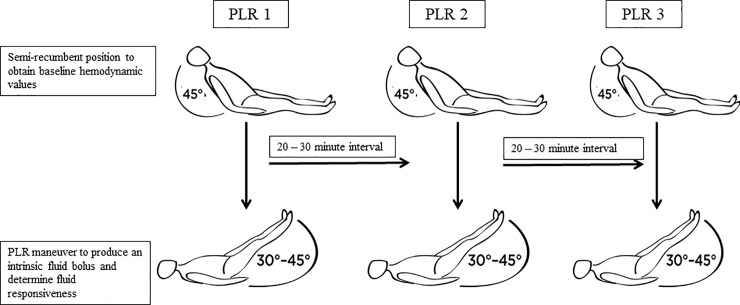
Serial passive leg raising (PLR) maneuver protocol.Patients were placed in the semi-recumbent position at 45° for 3 minutes and baseline hemodynamic values were recorded. PLR was induced by raising both lower extremities to 30–45° using a standard wedge pillow and held in this position for 3 minutes. After data collection, the patient was returned to the semi-recumbent resting position for 20–30 minutes. The PLR maneuver was repeated for 2 additional cycles.